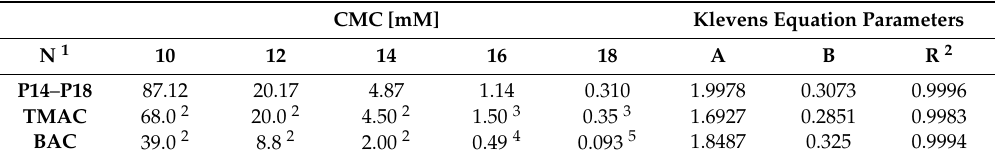
Table 2. CMC values and Klevens equation parameters of P14 – P18 , benzalkonium chlorides (BAC) and trimethylammonium chlorides